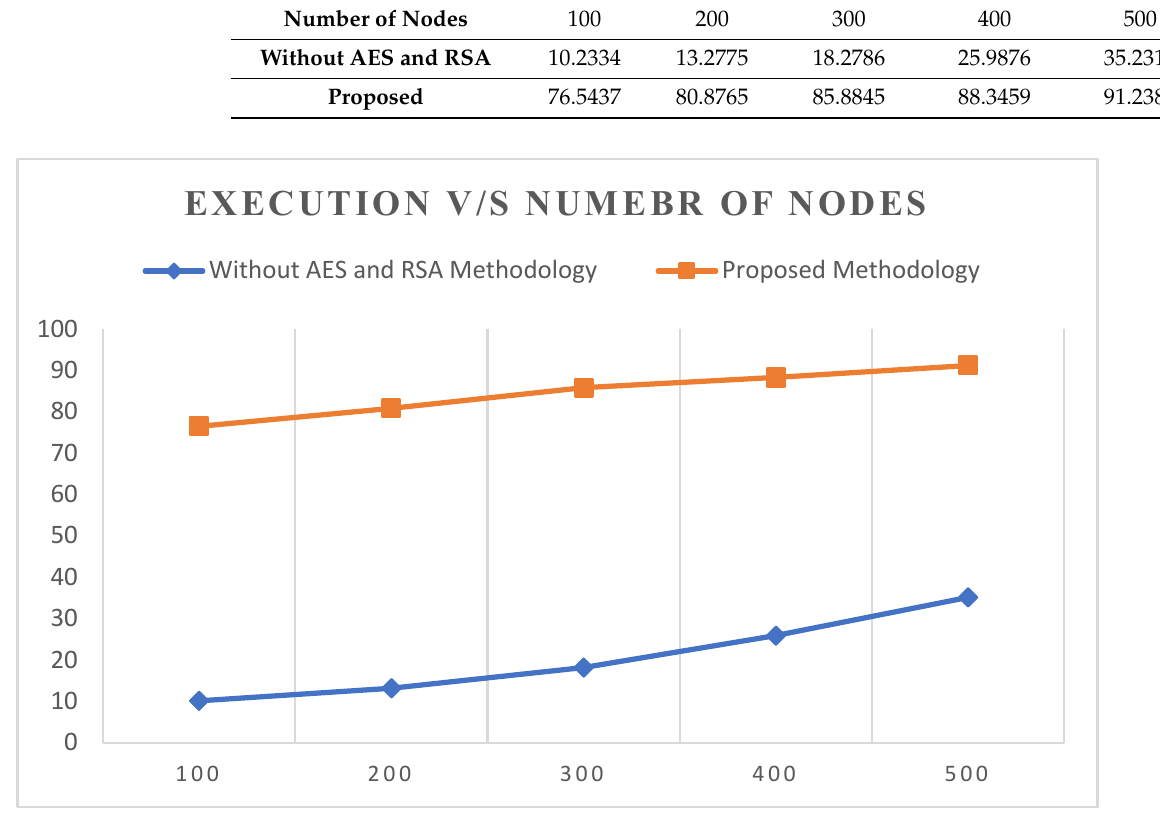
Figure 9. Execution vs. number of nodes.